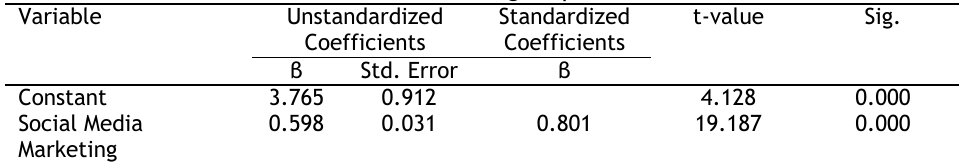
Table 1. The effect of social media marketing on purchase intentions